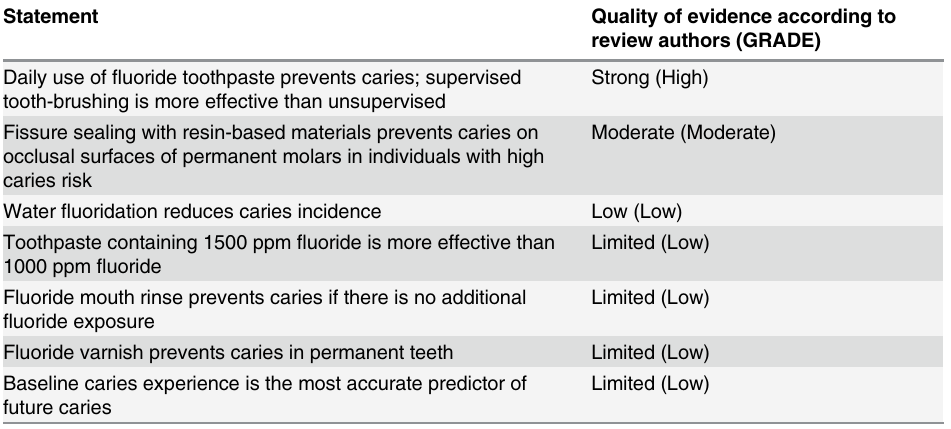
Table 6. Existing evidence-based knowledge for interventions related to pediatric dentistry.